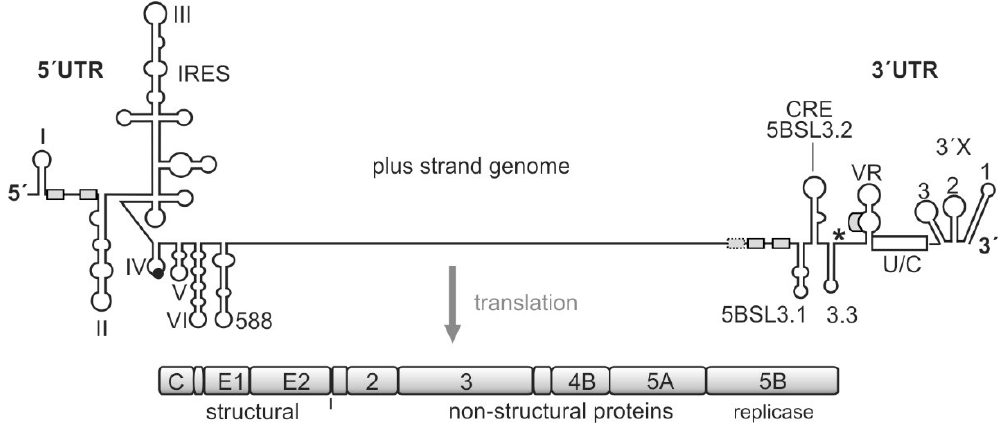
Figure 1. The hepatitis C virus (HCV) genome. The polyprotein open reading frame (ORF) is translated to a single polyprotein, which is co- and posttranslationally processed into the mature gene products, including the structural and the non-structural (NS) proteins. The gene segment for the NS5B replicase is located at the end of the polyprotein ORF. The HCV RNA genome contains several cis -elements, which are involved in the regulation of translation and genome replication [23,29–31]. In the 5 ′ UTR, the internal ribosome entry site (IRES) element mediates translation of the polyprotein ORF. The stop codon is indicated by an asterisk. Several important RNA secondary structure elements, which are involved in HCV genome replication, are located at the very 5 ′ - and 3 ′ -ends of the genome. Other replication cis -elements are also located in the coding region, in particular, in the 3 ′ -terminal portion of the NS5B replicase gene segment. These elements include the stem-loops 5BSL3.1, 3.2 (also called CRE for cis -replication element), and 3.3. microRNA-122 (miR-122) target sites are indicated by small boxes.